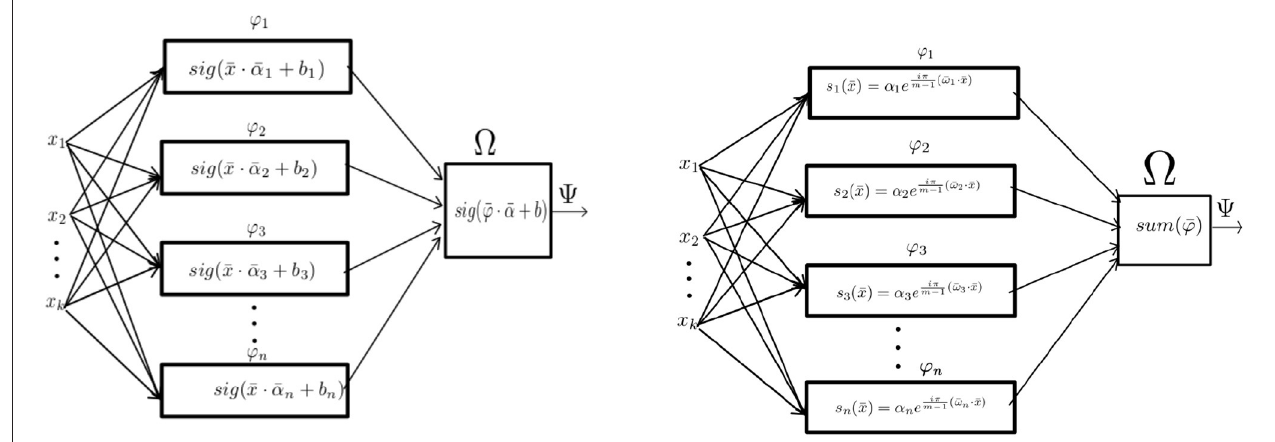
FIGURE 3 | From left to right: The Implementation of the MLP with one hidden layer as a parallel machine and the implementation of the signal perceptron.